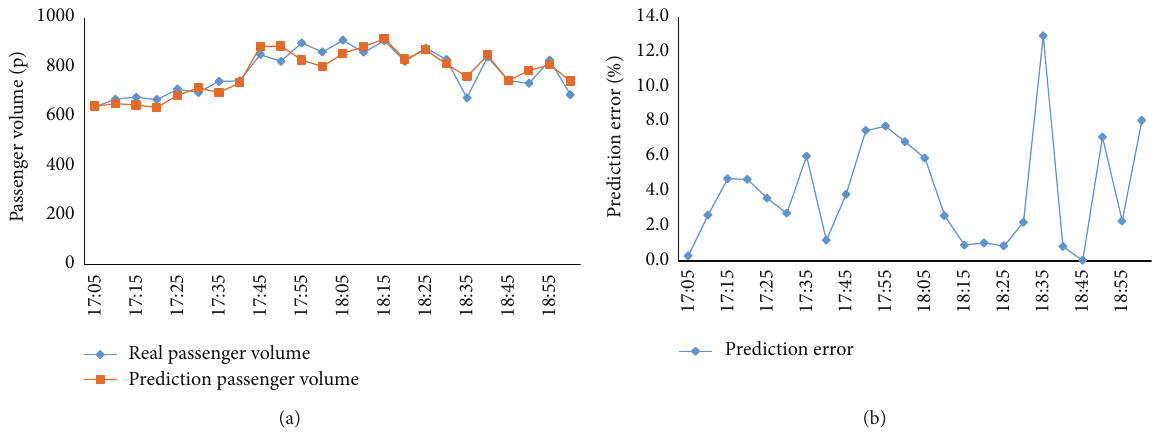
Figure 7: Forecasting the result for each 5 minutes in evening peak hour using nonparametric regression.